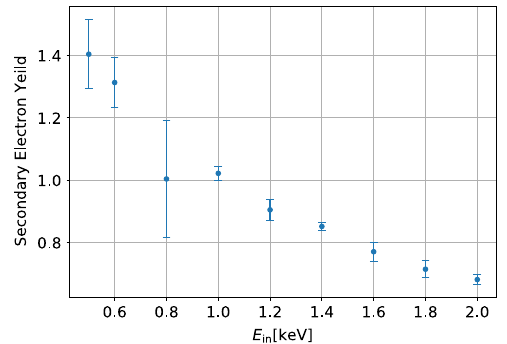
FIG. 1. The secondary electron yield (SEY) of the MgO samples with the DLC coating. The blue points denote the SEY of the DLC coating with a thickness of 0 . 5 ½ μ m (cid:2) . The error bars denote the statistical error of 1 σ